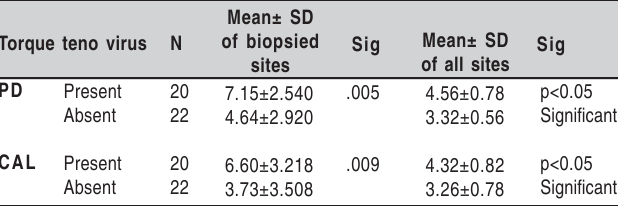
Table 2. Mean PD and mean CAL by TT virus presence